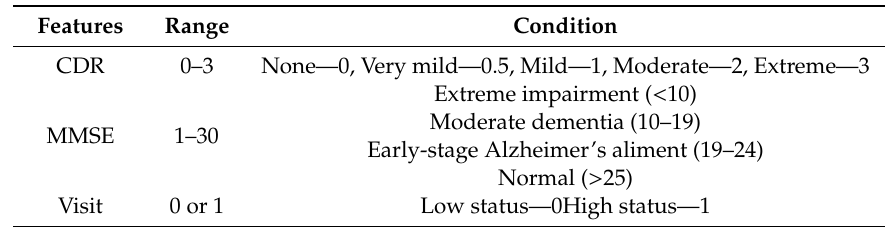
Table 5. Scoring